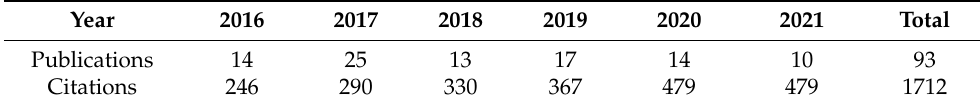
Table 7. Publication and citation counts based on the analysis pattern: TS = ((renewable*) AND energy security educ*). Source: Web of Science database.